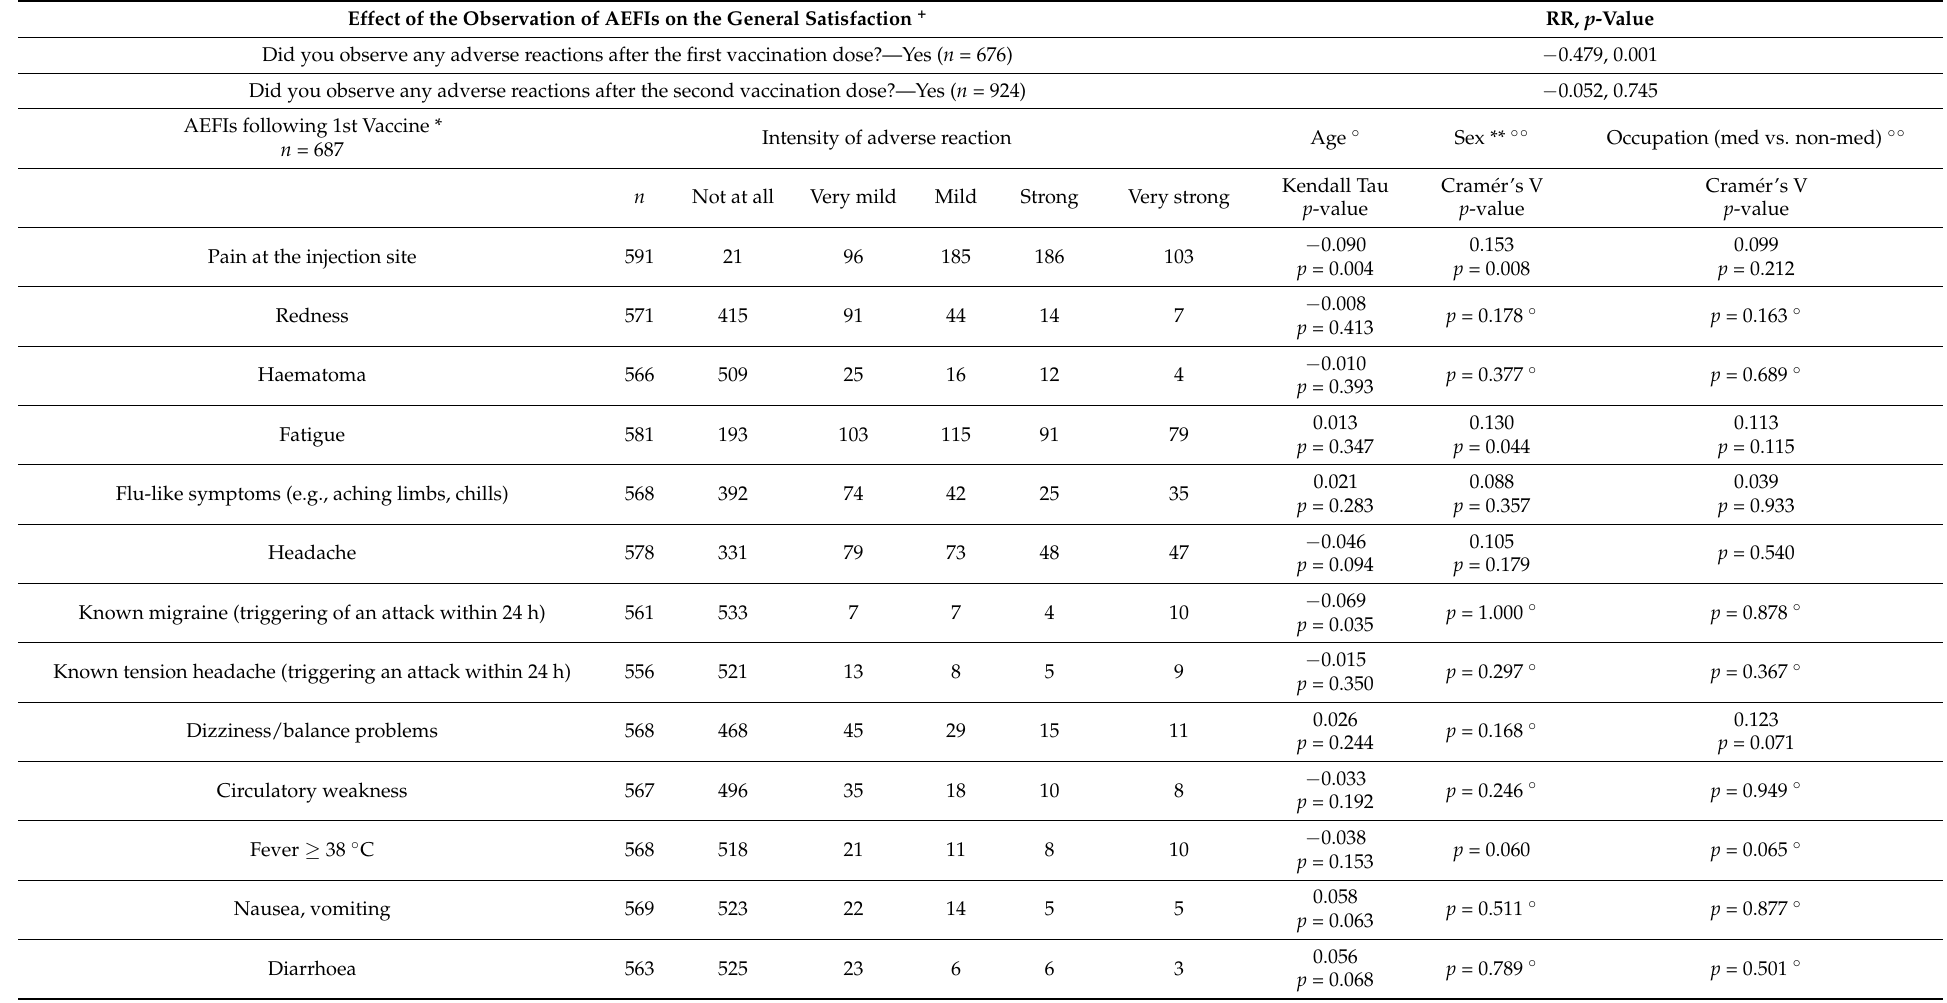
Table 3. Adverse events following immunization observed and reported by